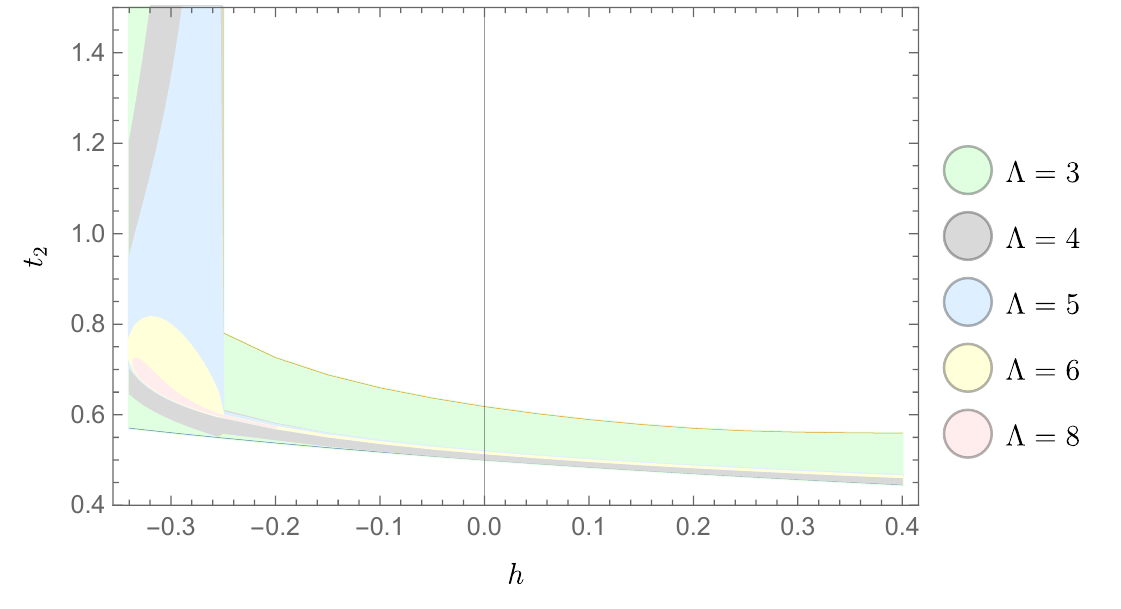
Figure 8 . The allowed region for t 2 when we fix g = 1 and vary h . In the region where the potential is bounded from below i.e. h ≥ − 1 the convergence gets much